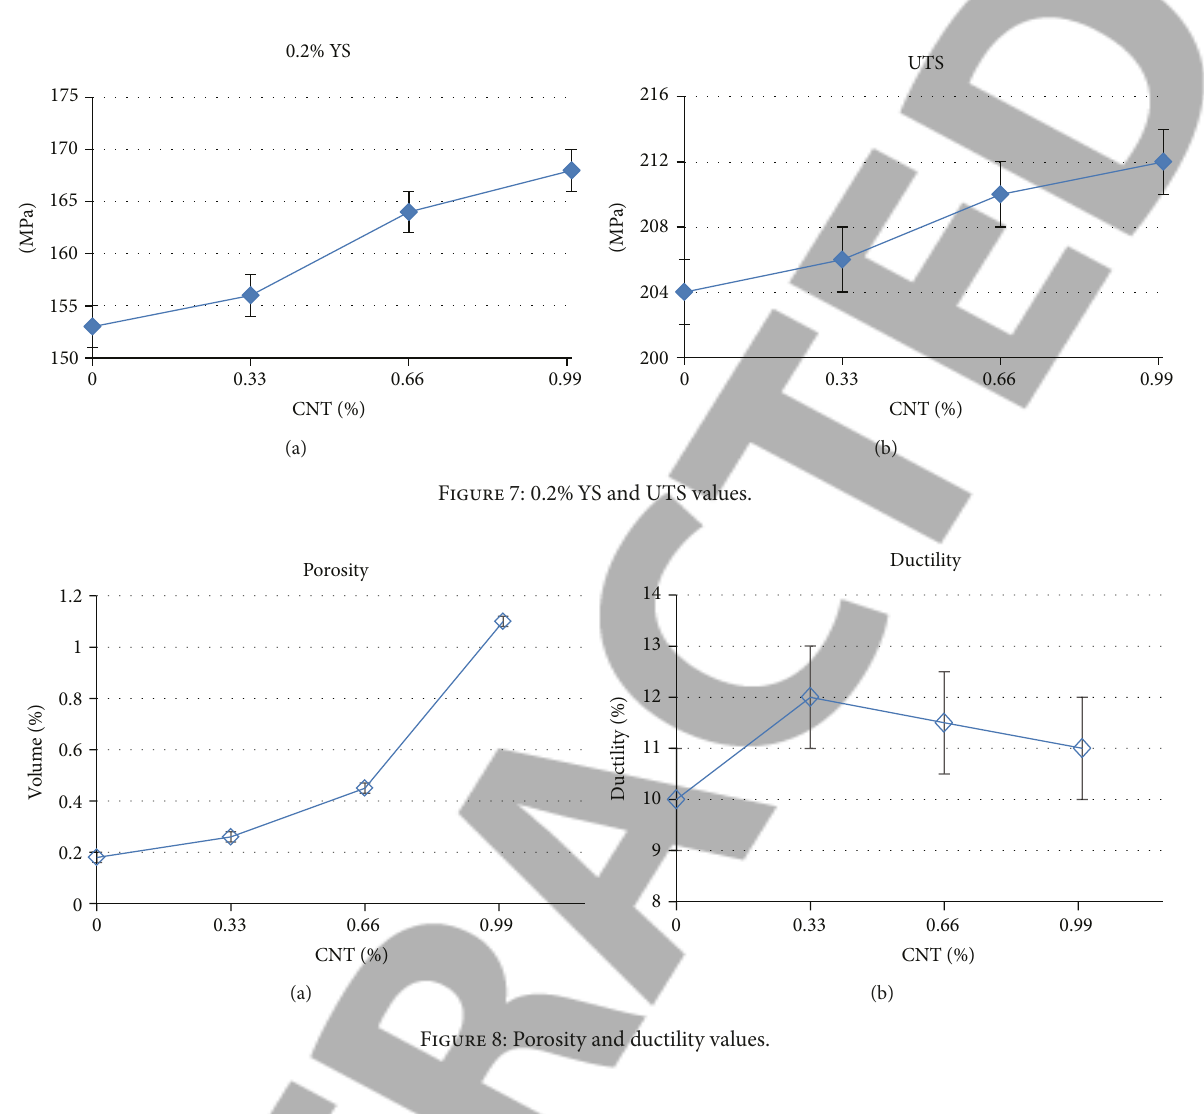
Figure 8: Porosity and ductility